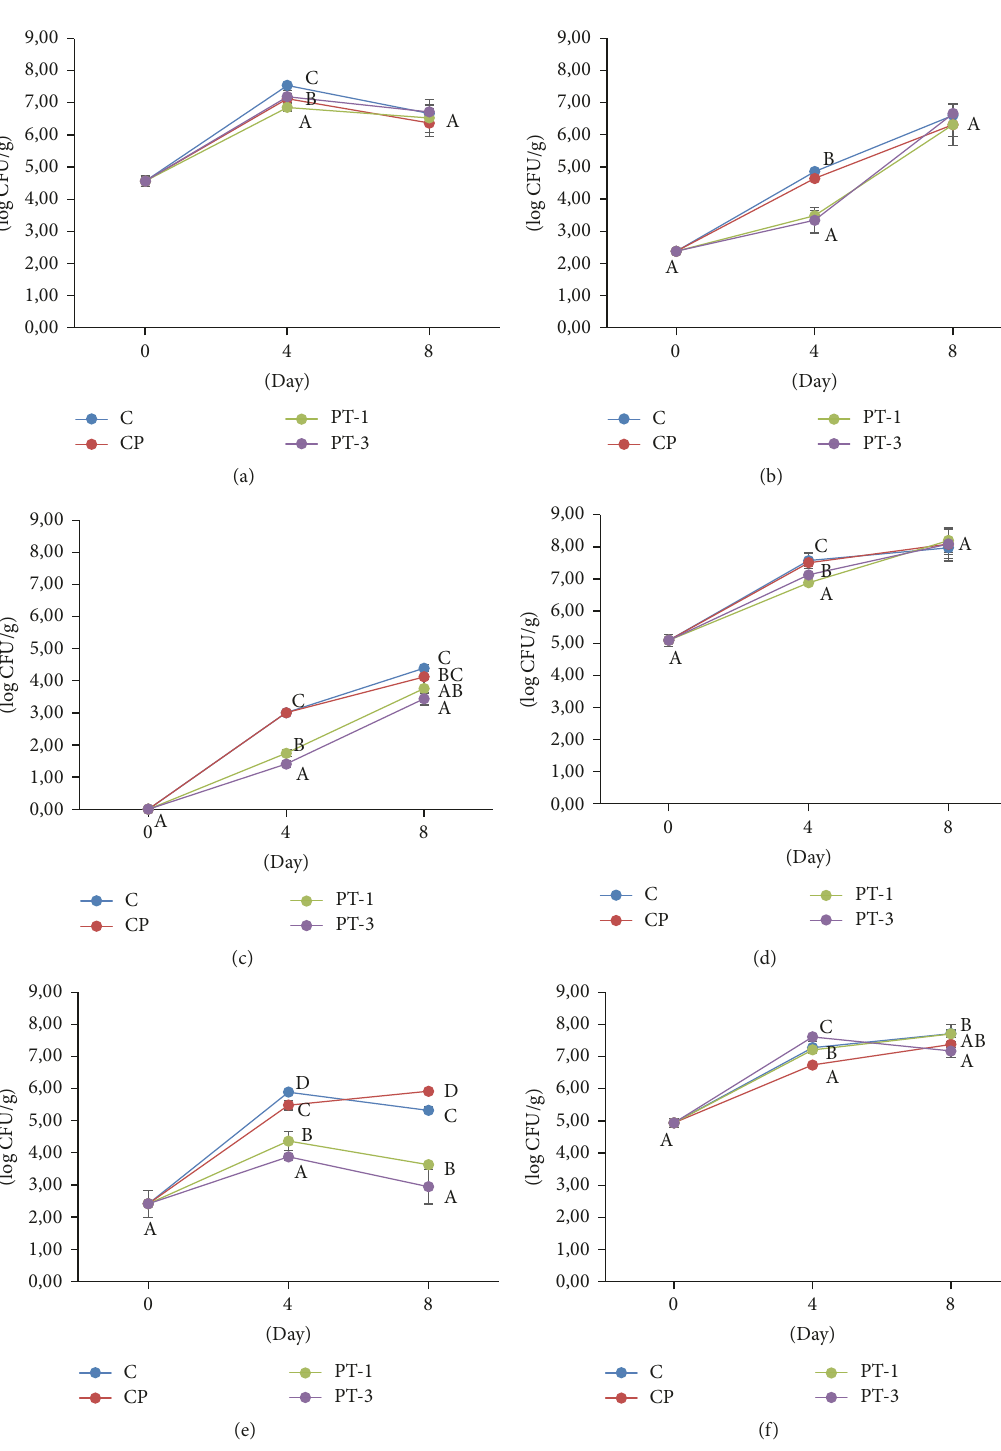
Figure 2: Evolution of the natural microbiota of WPI-Thy coated hake fillets stored under air conditions. C: control; CP: control-WPI; PT-1: WPI + Thy 1%; PT-3: WPI-Thy 3%. (a) Total viable counts; (b) lactic acid bacteria; (c) Enterobacteriaceae ; (d) psychrotrophic bacteria; (e) H 2 S- producing bacteria; (f)